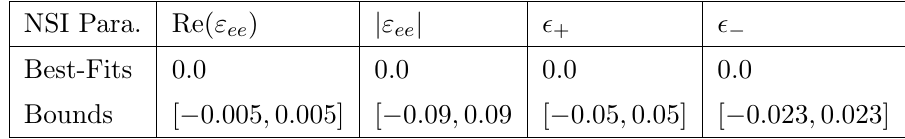
Table 4 . Future prospects: 1-parameter at-a-time source NSI parameter bounds at the 90%